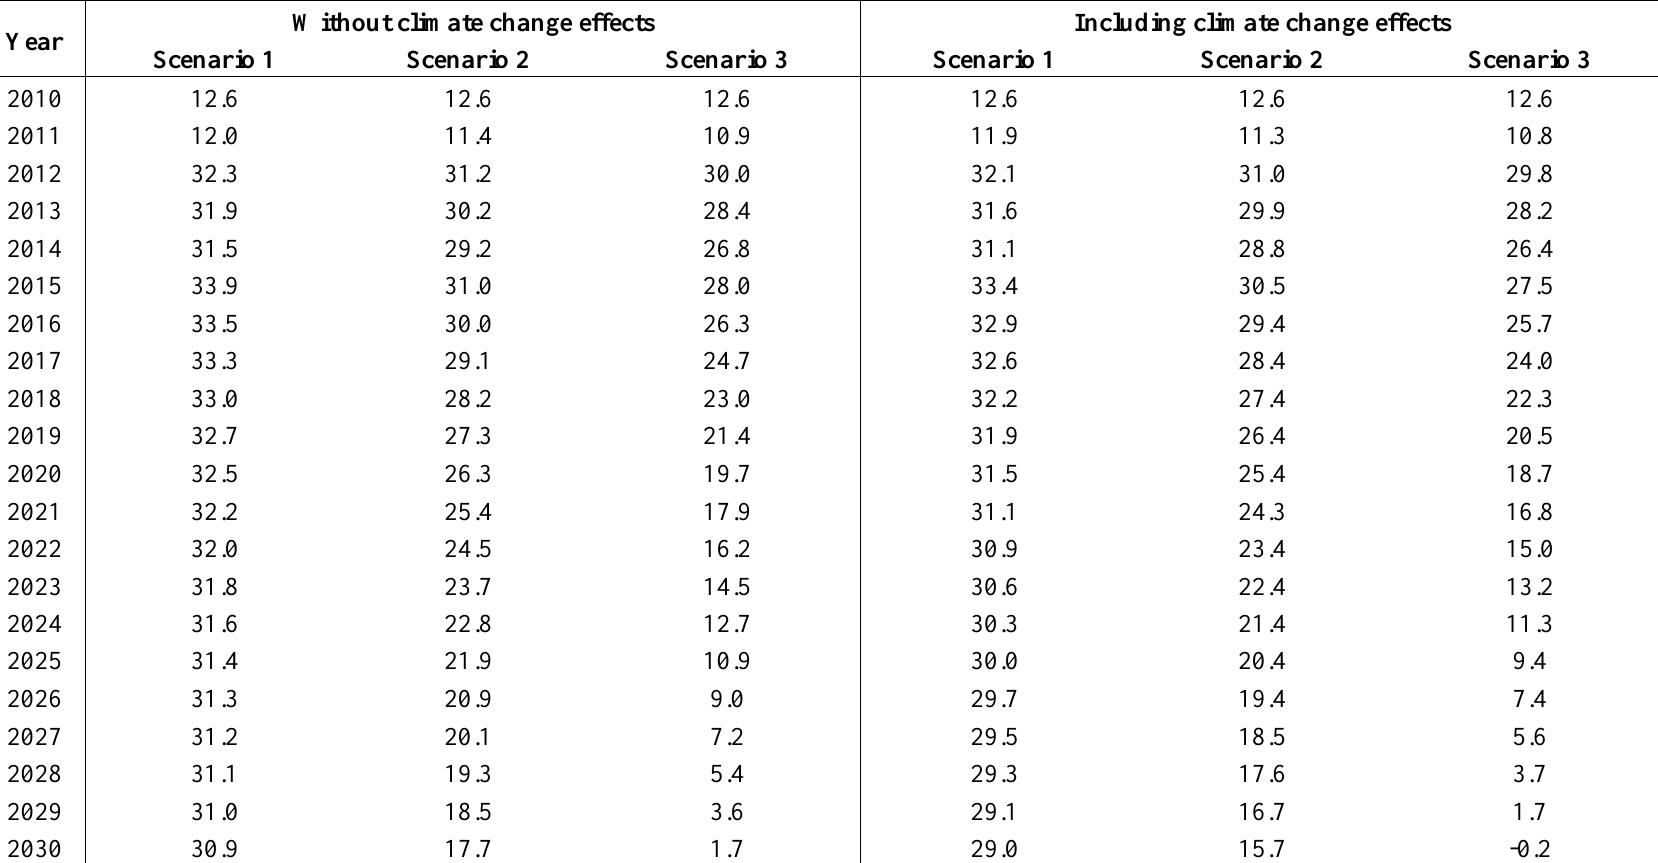
Table 4. Water surplus (annual demand minus annual supply in million m 3 per year) in the residential sector due to new desalination plants, by scenario.